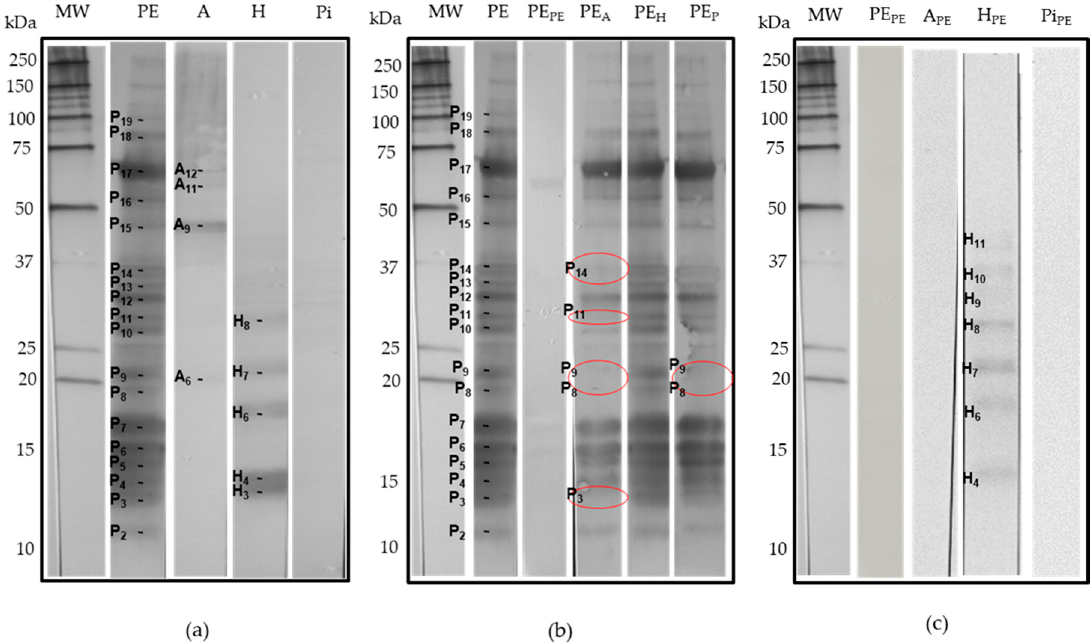
Figure 5. Reciprocal inhibition immunoblotting. ( a ) Peanut and tree nut extracts immobilized strips incubated with the uninhibited serum pool (PO): PE, peanut; A, almond; H, hazelnut and Pi, pistachio. ( b ) Peanut extract immobilized strips incubated with PO inhibited with each nut extract: PE, noninhibited with peanut; PE PE , inhibited with peanut; PE A , inhibited with almond; PE H , inhibited with hazelnut and PE P , inhibited with pistachio. ( c ) Tree nut extract immobilized strips incubated with PO inhibited with the peanut extract.